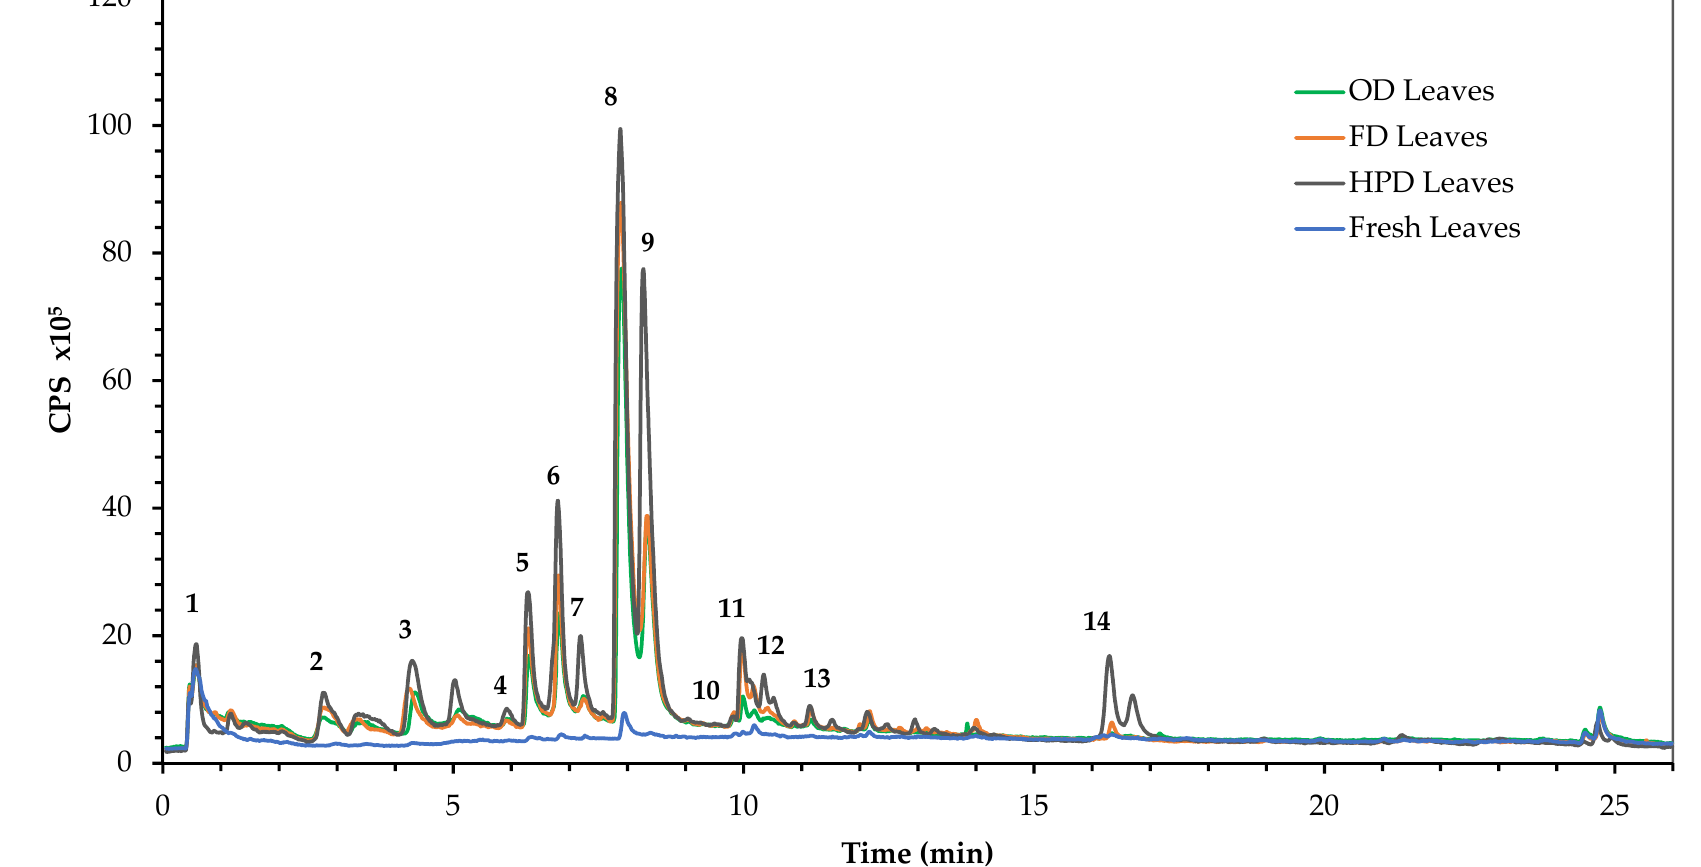
Figure 3. Phenolic profile of fresh or dried leaves of U. dioica plants collected in the wild. Leaves were dried with different methods: freeze-drying (FD), oven-drying (OD) and heat pump drying (HPD). The blue line represents the chromatogram of fresh leaves, the orange line the chromatograph of freeze-dried leaves, the green line the chromatogram of the oven-dried leaves and the black line the chromatograph of the heat pump-dried leaves. Numbers refer to the identified phenolic compounds reported in Table 1.